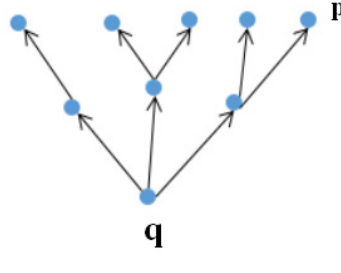
Figure 1. A rooted tree T .